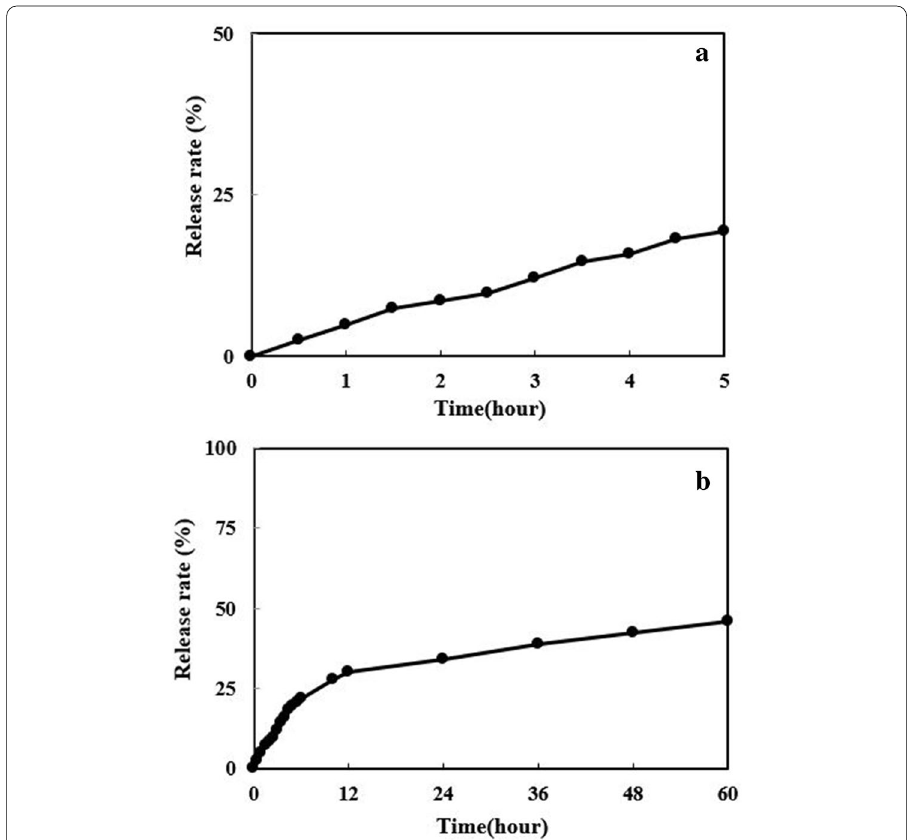
Fig. 9 Release of basil oil in the chitosan microcapsules dissolving alkaline sweat solution by over time ( a ) in 5 h, ( b ) in 60 h